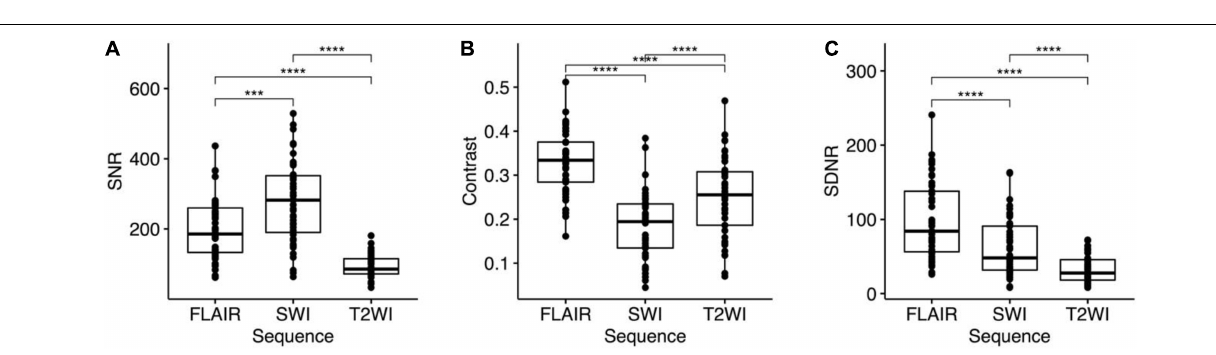
FIGURE 5 | One-way repeated measures analysis of variance (ANOVA) and post hoc tests for (A) signal-to-noise ratio (SNR), (B) contrast, and (C) signal difference-to-noise ratio (SDNR) the STN on FLAIR, SWI, and T2WI. Bonferroni multiple testing correction for multiple comparisons in the post hoc tests. All the p < 0.001 for ANOVA and post hoc tests of SNR, contrasts, and SDNR. *** p ≤ 0.001 and **** p ≤